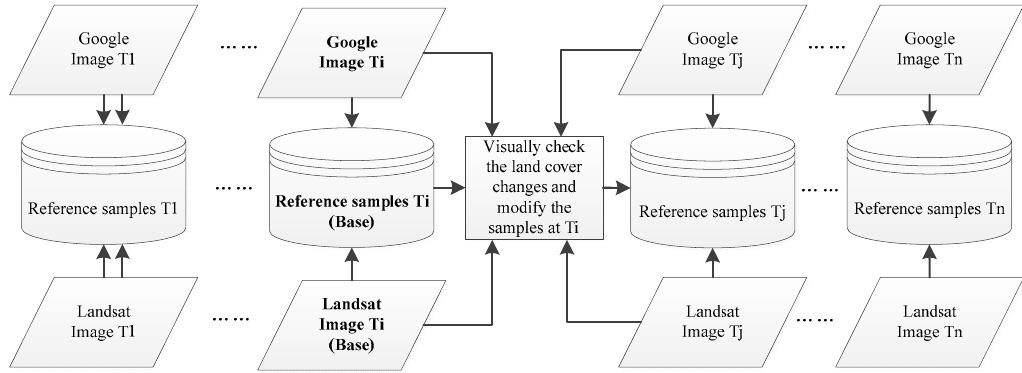
Figure 4. Illustration of the construction of reference samples at time Tj based on the samples at time Ti.